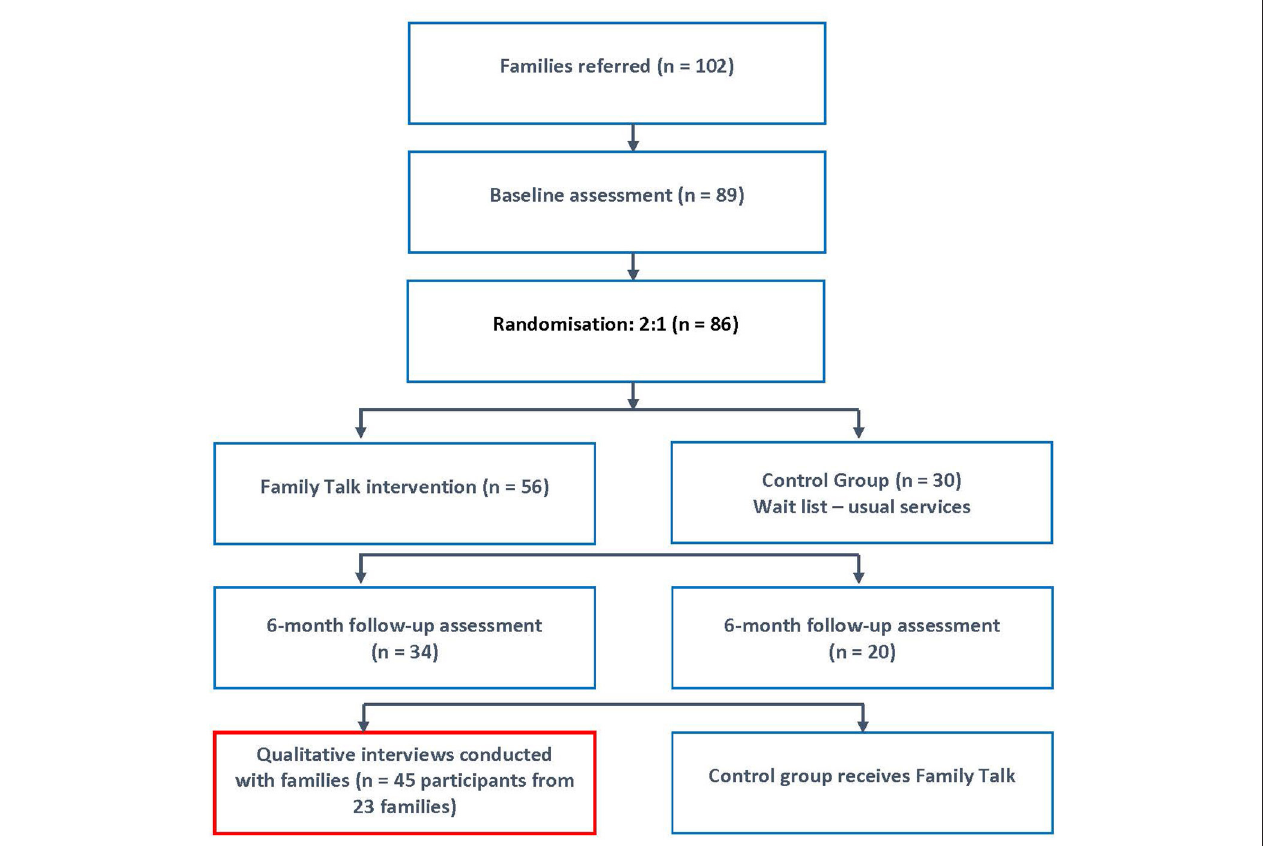
FIGURE 2 | Study flow